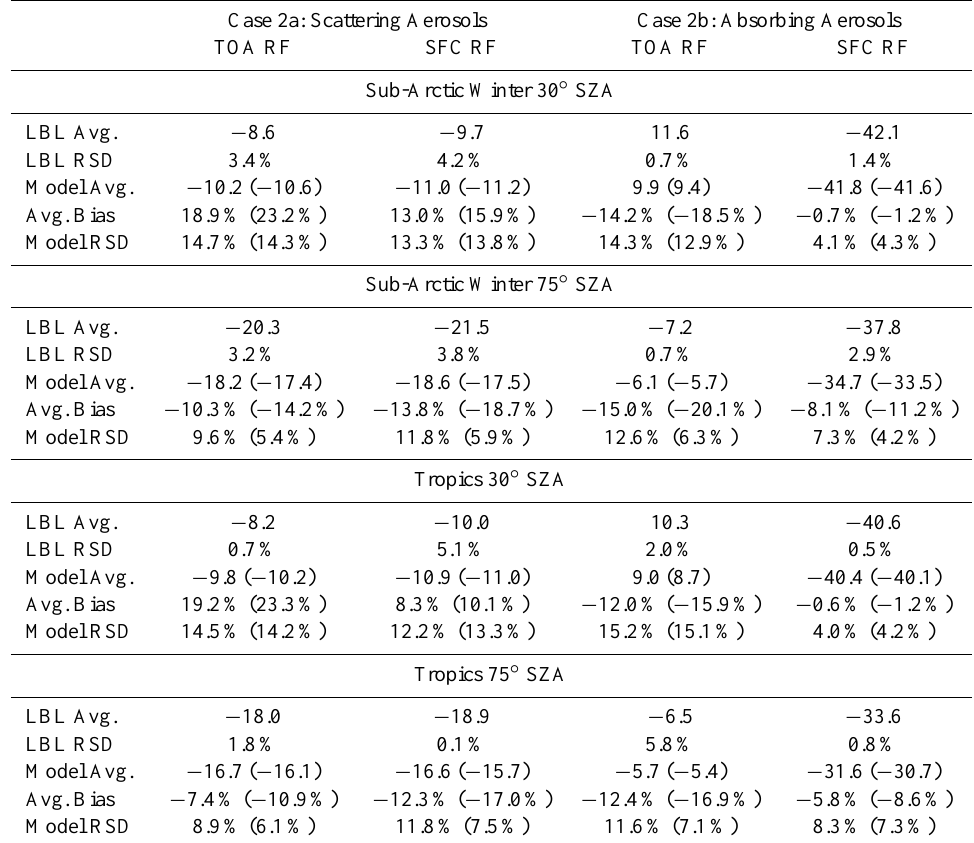
Case 2a: Scattering Aerosols Case 2b: Absorbing